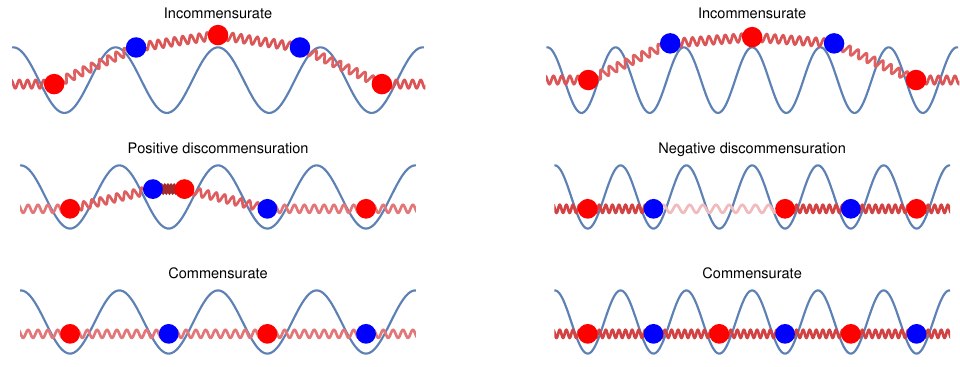
Figure 1 . Cartoon of discommensurations. Left panel: (cid:21) k > (cid:21) p potential minima, positive discommensuration is formed. Right panel: (cid:21) k < (cid:21) p then minima, negative discommensuration is formed. Note in both cases the discommensuration changes the staggered \red-blue" order in comparison with the \parent" commensurate